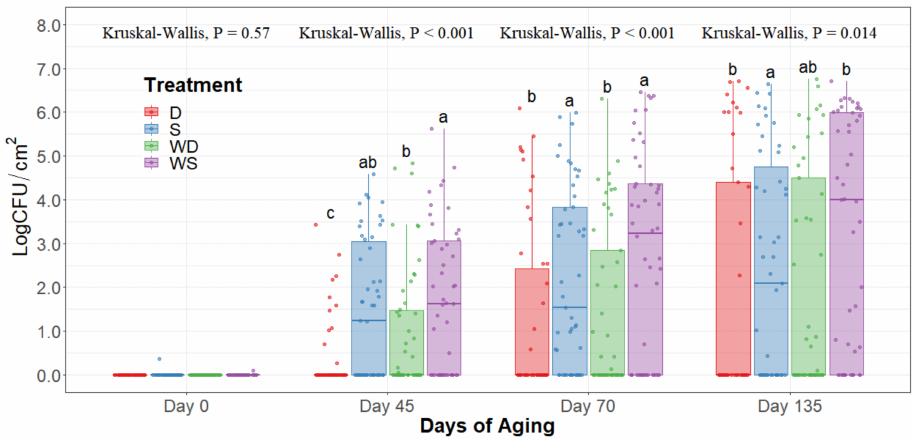
Figure 5. Enterobacteriaceae counts of striploins at day 0, 45, 70, and 135 of refrigerated storage. The horizontal line within the box plot represents the median. The box upper and lower limits represent the interquartile range, and the bars represent the 1.5xInterquartile Range. D = No Wash Dry chill, S = No Wash Spray chill, WD = Wash Dry chill, WS = Wash Spray chill. a–c Box plots with different letters within each sampling date are significantly different ( p <